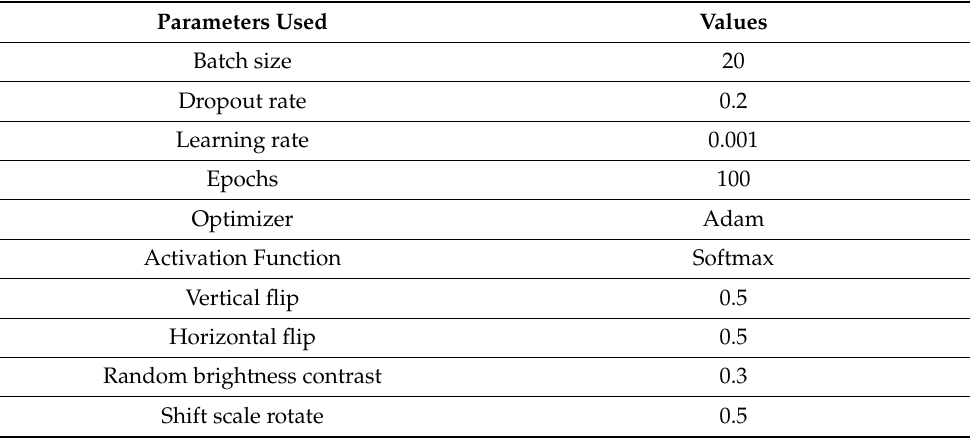
Table 1. Network Hyper parameters setting in our proposed methodology.